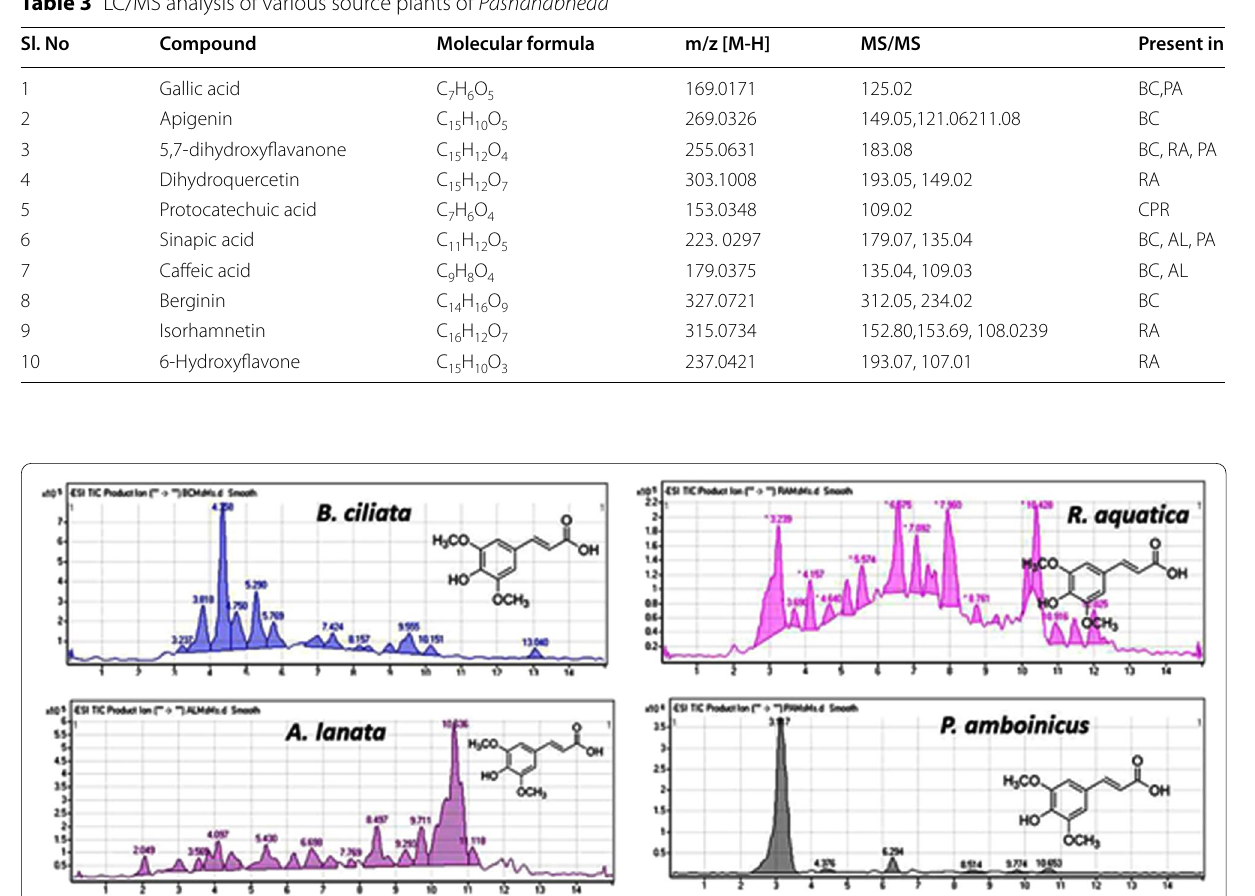
Fig. 2 LC/MS Total Ion Chromatogram (TIC) of selected source plants of